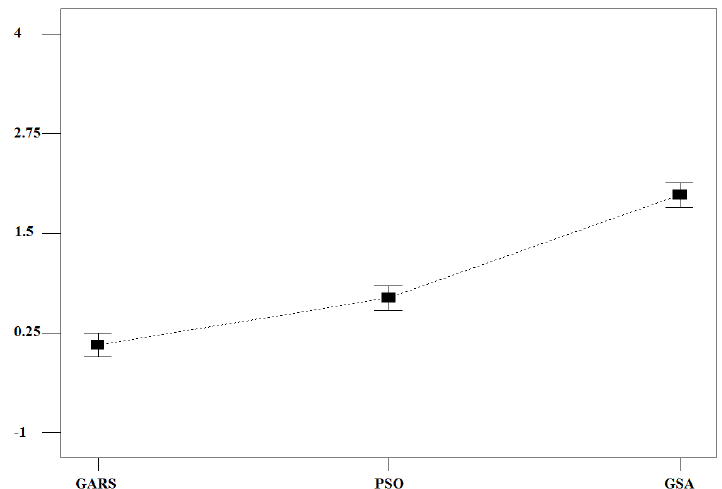
Figure 6. LSD bar chart at 95% confidence